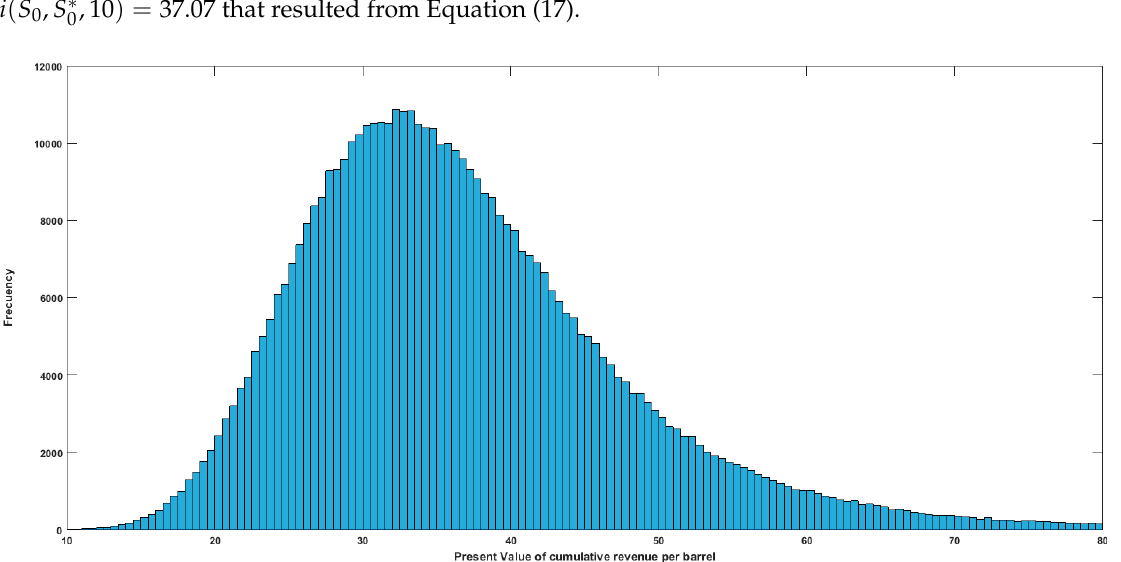
Figure 6. Probability distribution of the PV of income from tight oil ($/bbl).